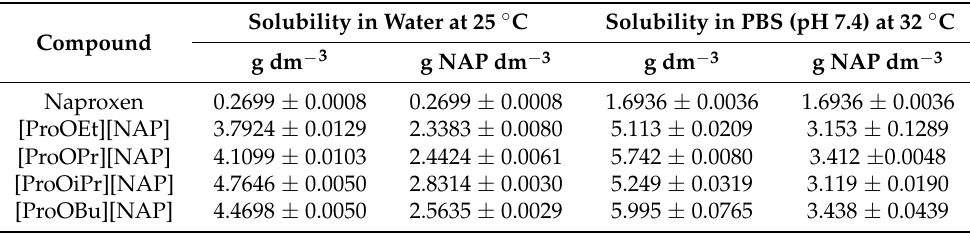
Table 5. The solubility of naproxen and L-proline alkyl ester naproxenates in water at 25 ◦ C and PBS (pH 7.4) buffer at 32 ◦ C. Solubility in Water at 25 ◦ C Compound